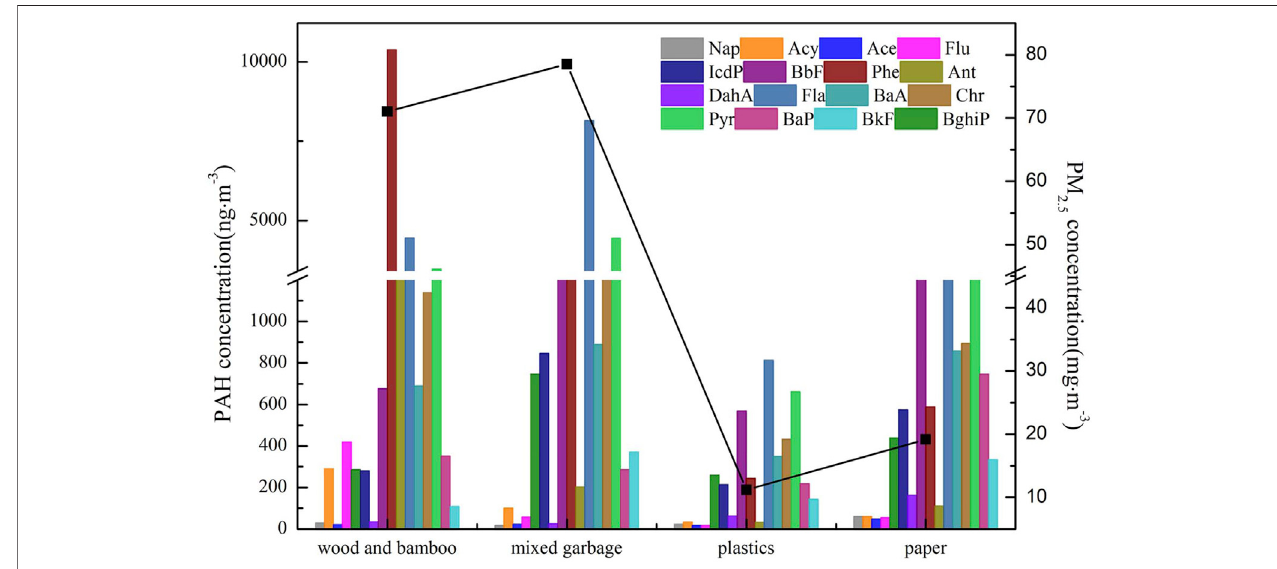
FIGURE 1 | The distribution characteristics of in PM 2.5 and PAHs concentrations from open burning of